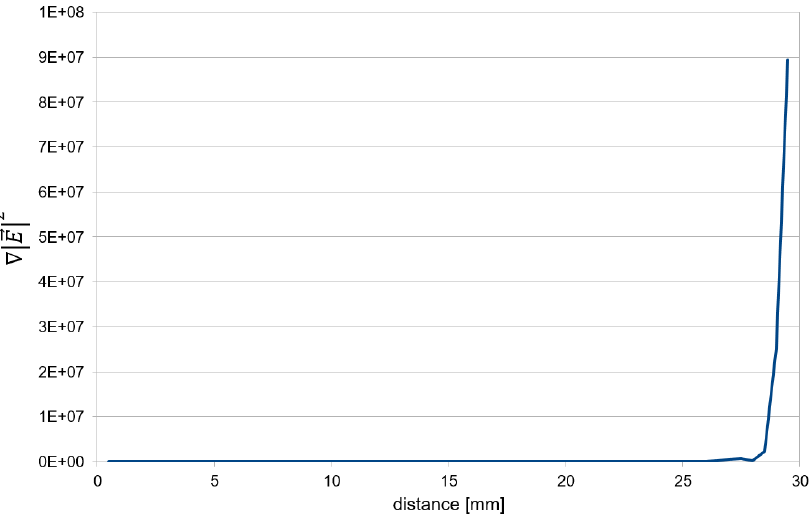
2 2 → in relation to the distance from the grounded wire mesh E | in relation to the distance from the grounded wire mesh